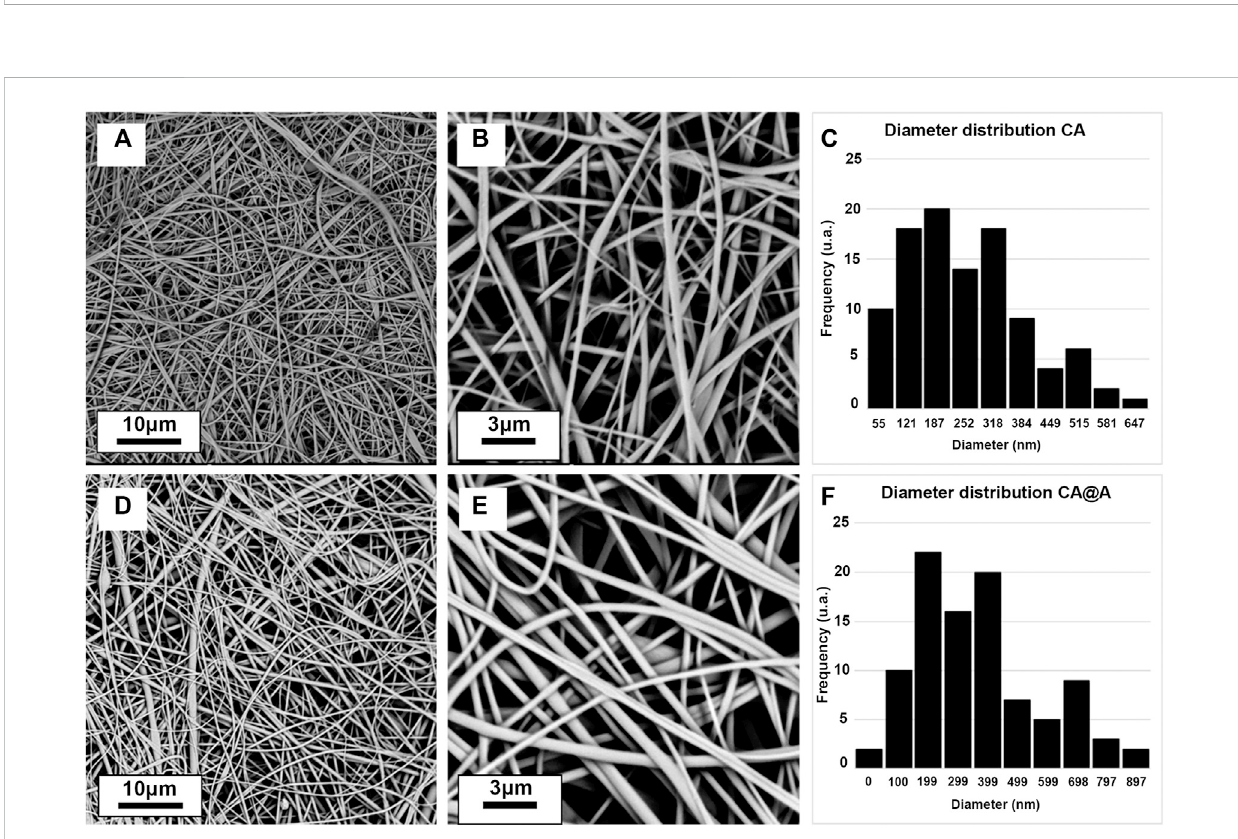
FIGURE 3 Scanning electron microscope (SEM) images of cellulose acetate (CA) and cellulose acetate annatto (CA@A) nano fi bers at different magni fi cations andtheirsizedistribution. (A,B) MorphologyofCAnano fi berswithdifferentmagni fi cations. (C) DiameterdistributionofCAnano fi bers. (D,E) Morphology of CA@A nano fi bers with different magni fi cations. (F) Diameter distribution of CA@A nano fi